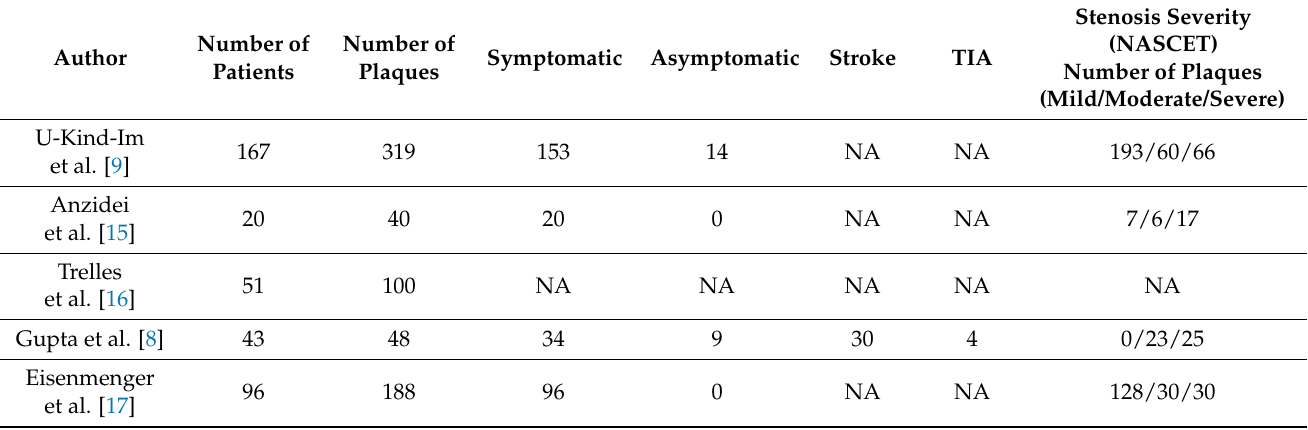
Table 2. Symptomatic status and stenosis severity of the included studies. Four studies incorporated data on symptomatic status and stenosis severity.